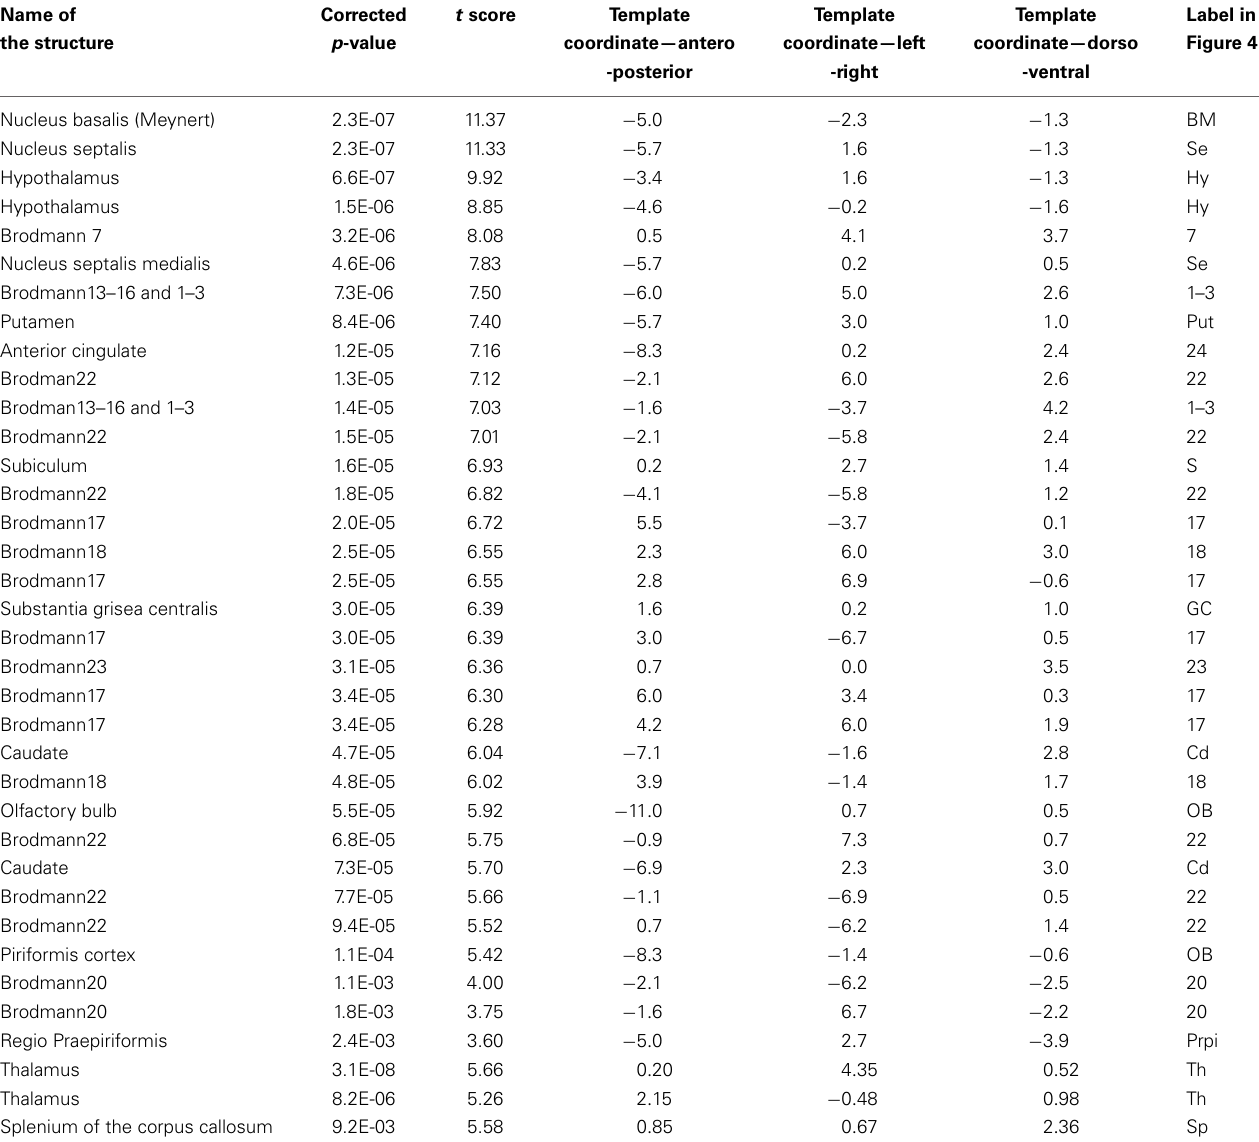
Table 1 | Clusters showing significant atrophy on the basis of VBM analysis in mouse